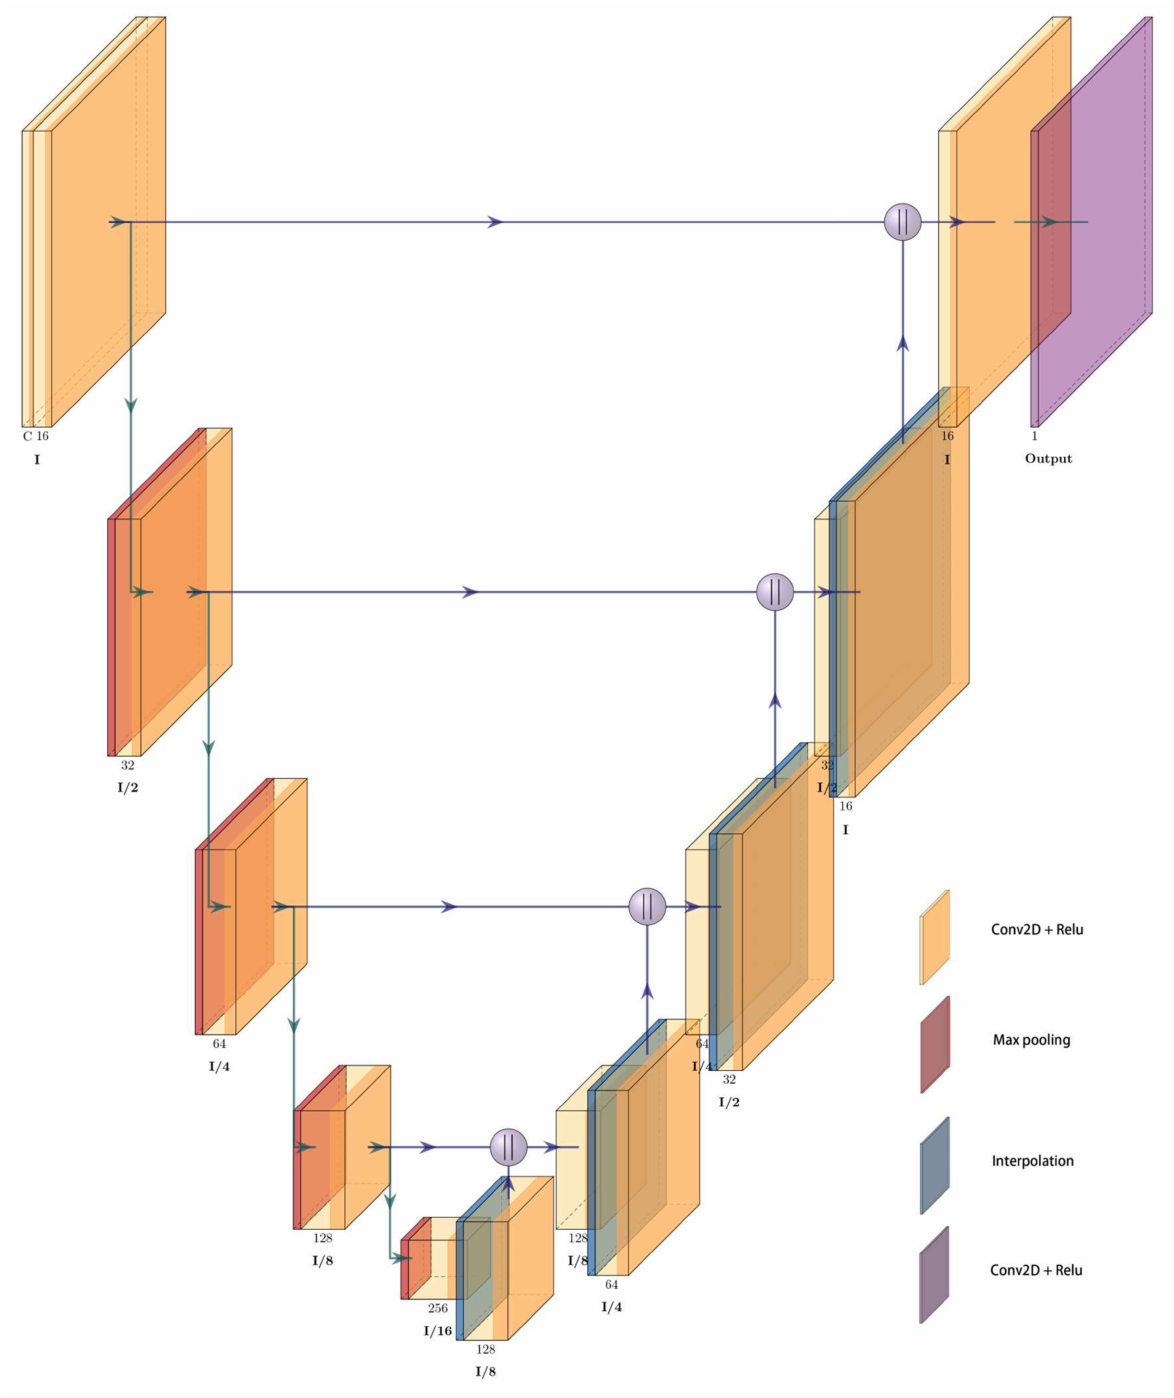
Figure 5. U-net model architecture. Boxes of different colors represent layers of different types. Circles with 2 lines represent the concatenation operations of two matrices. The numbers below each box denote the number of layer channels. Bold black letters below the numbers denote the edge lengths of the matrix, where I is the input edge length (M,